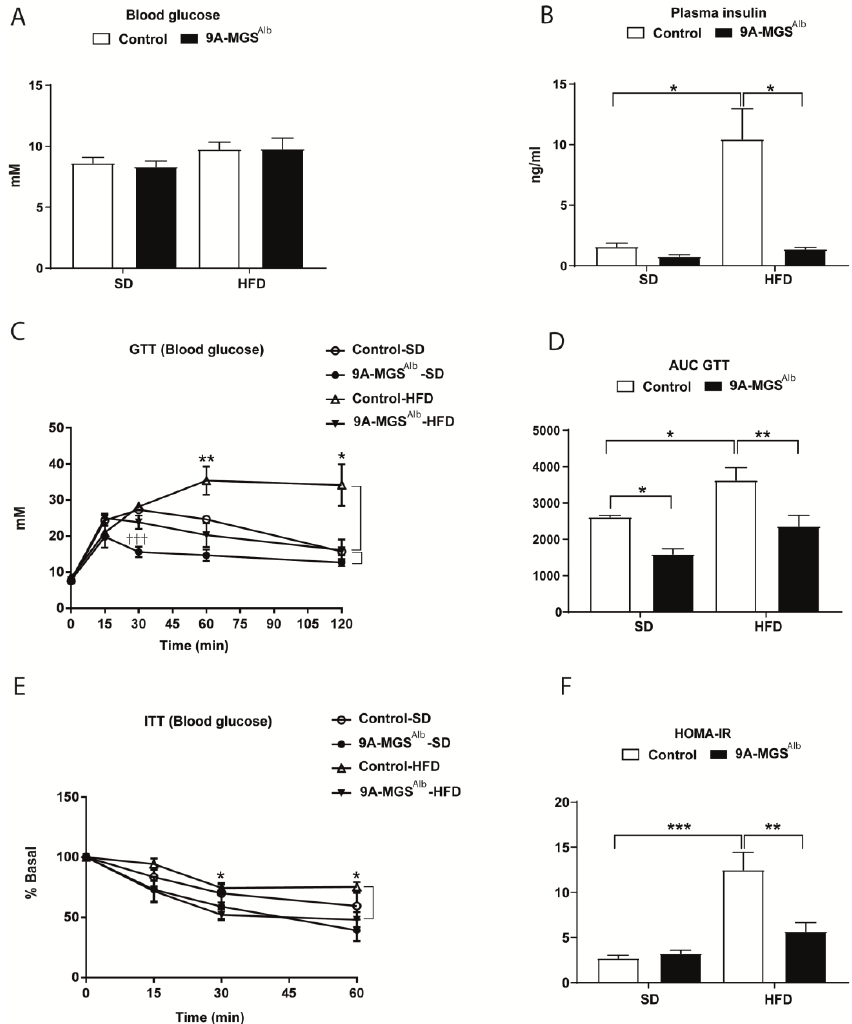
Figure 4. ( A ) Blood glucose concentration in fed condition. ( B ) Plasma insulin concentration in fed condition (* p < 0.05). ( C ) GTT curve for glucose. For GTTs, mice were fasted for 16h and injected with 2 g glucose/kg body weight i.p. (††† p < 0.001, control-SD vs 9A-MGS Alb -SD; * p < 0.05 and ** p 2 g glucose/kg body weight i.p. (††† p < 0.001, control-SD vs. 9A-MGS Alb -SD; * p < 0.05 and ** p < < 0.01 control-HFD vs 9A-MGS Alb -HFD). ( D ) Area under the curve (AUC) for GTT (* p < 0.05, **p<0.01). ( E ) ITT curve for glucose. For ITTs, mice were fasted for 6h and injected with 0.75 units insulin/kg body weight i.p. (* p < 0.05 control-HFD vs 9A-MGS Alb -HFD). ( F ) HOMA-IR (** p < 0.01, *** p < 0.001). Data are mean ± SEM. n = 5 – 10/group.